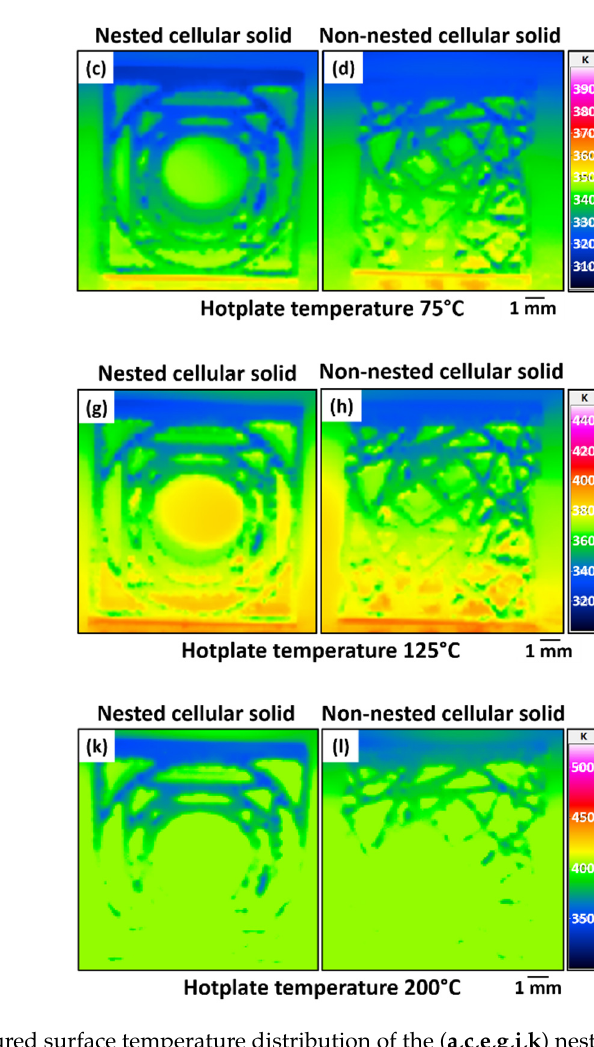
Figure 9. Experimentally measured surface temperature distribution of the ( a , c , e , g , i , k ) nested and ( b , d , f , h , j , l ) non-nested cellular solids for hotplate temperature ( a , b ) 50 °C; ( c , d ) 75 °C; ( e , f ) 100 °C; ( g , h ) 125 °C; ( i , j ) 150 °C; and ( k , l ) 200 °C. The legend in Figure 9 shows the temperature in Kelvin.